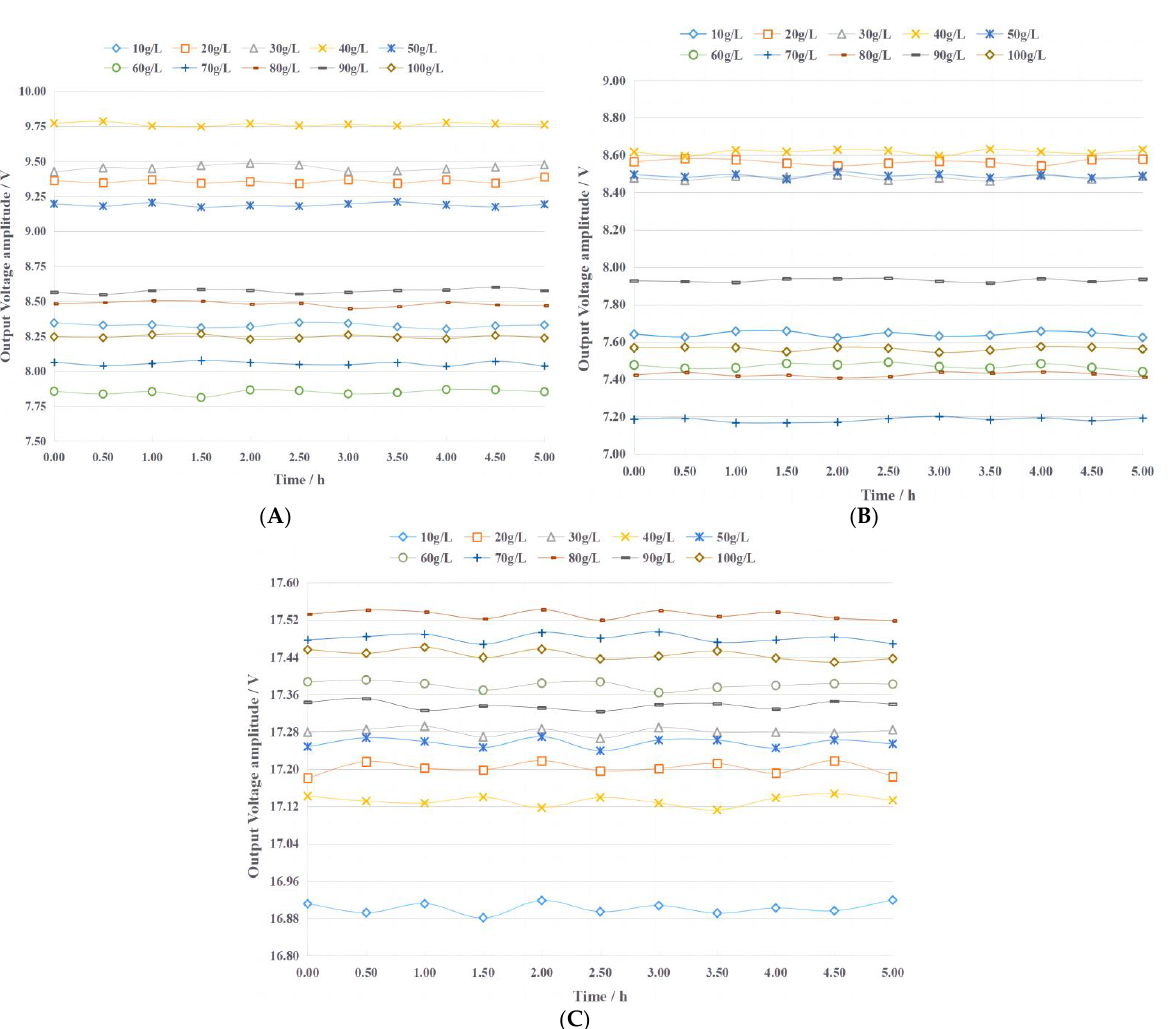
Figure 4. The stability test results of the fertilizer detection sensor under different frequency excitation signals. ( A ) 50 kHz ( B ) 500 kHz ( C ) 5000 kHz.